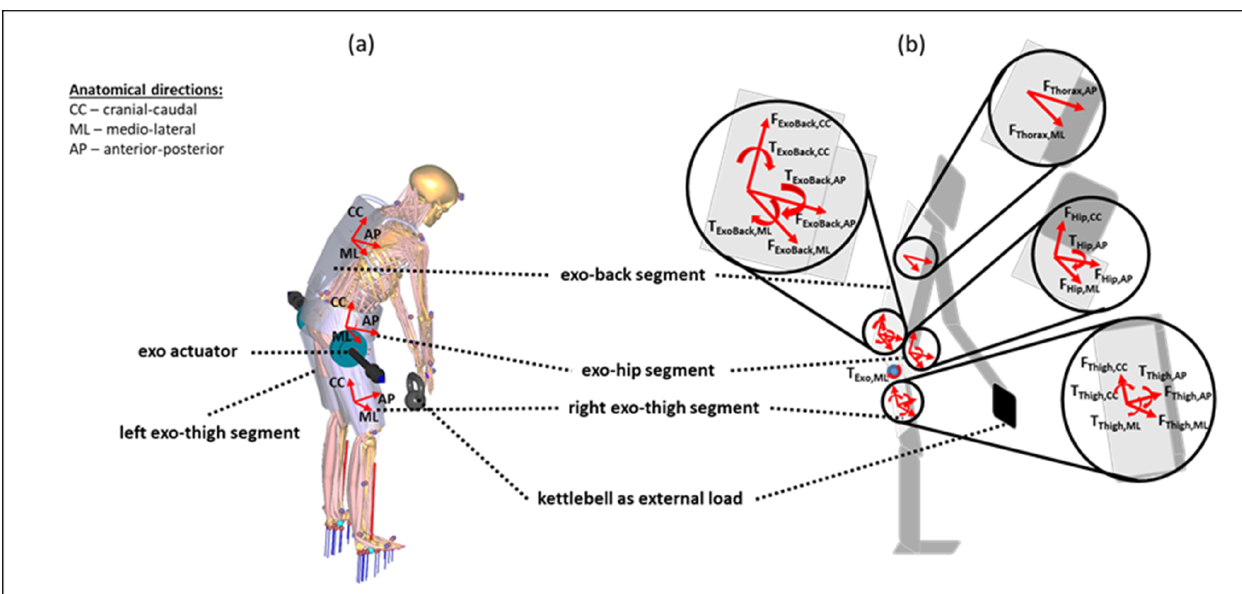
Figure 3. Generic exoskeleton–human model with anatomical directions as the basis for the orientations of the axes of rotation and translation for the interaction forces and moments. The model is illustrated with anatomical directions ( a ) and implemented interaction forces and moments ( b ) based on Table 1. Further, the axes of the actuator torques are outlined.